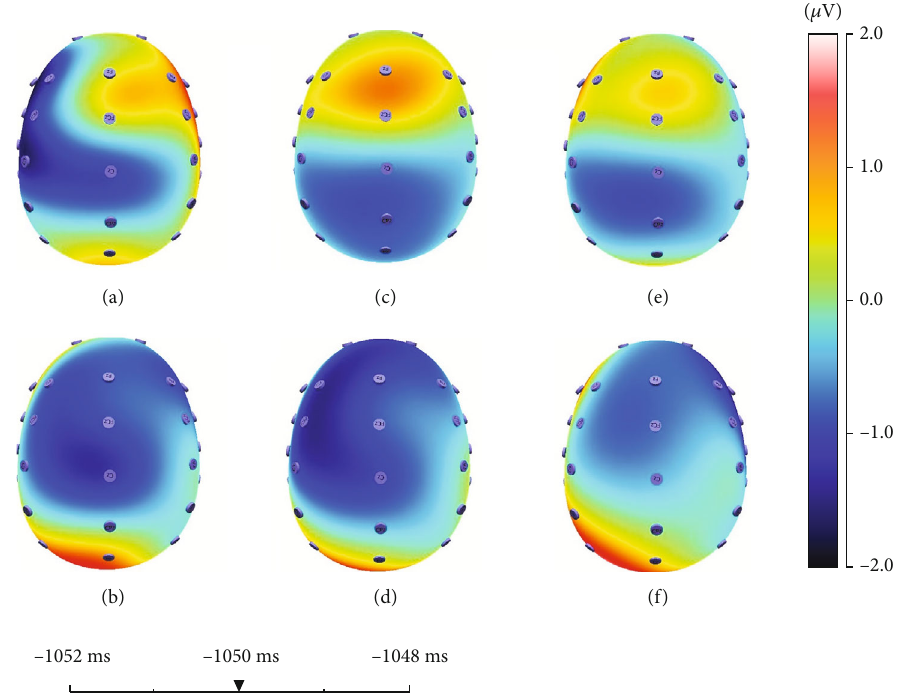
Figure 4: The e ff ects of di ff erent expectations on the various regions of the brain 50 ms before making a choice. The red region tends to show obvious positive characteristics, and the blue region tends to show negative ones. (a) The fi rst experiment where E = 5 , and the subjects will choose 5. (b) The fi rst experiment where E = 5 , and the subjects will choose 25. (c) The second experiment where E = 7 , and the subjects will choose 5. (d) The second experiment where E = 7 , and the subjects will choose 35. (e) The third experiment where E = 10 , and the subjects will choose 5. (f) The third experiment where E = 10 , and the subjects will choose